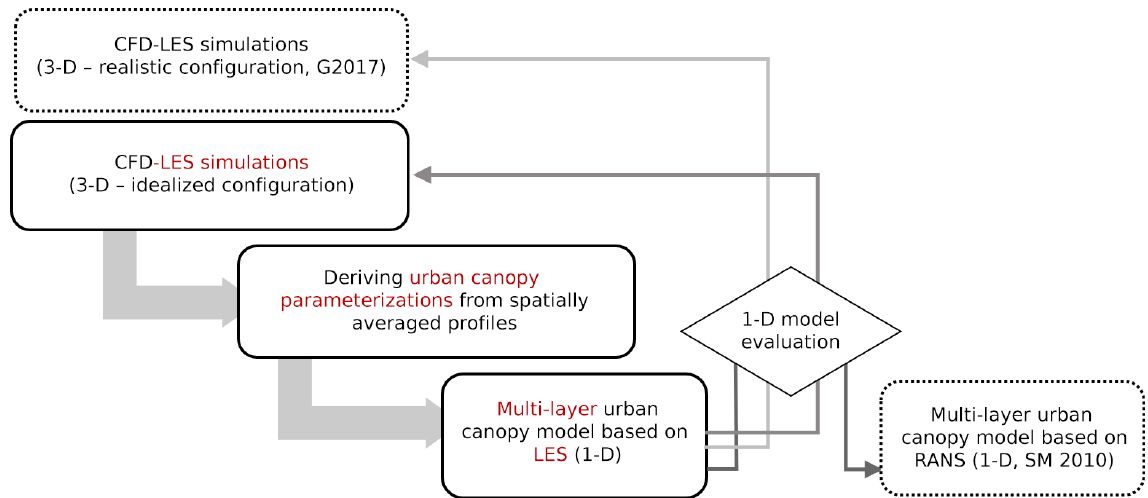
Figure 2. Flow chart of the present study. Three-dimensional LES simulations are performed and vigorously tested in an idealized configura- tion of buildings. Then, using the spatially averaged profiles, urban canopy parameterizations of the multi-layer (column) model are revisited. The updated multi-layer (1-D) model is then evaluated against the UCPs in Santiago and Martilli (2010), the 3-D simulation results, as well as LES results in a realistic configuration by Giometto et al.